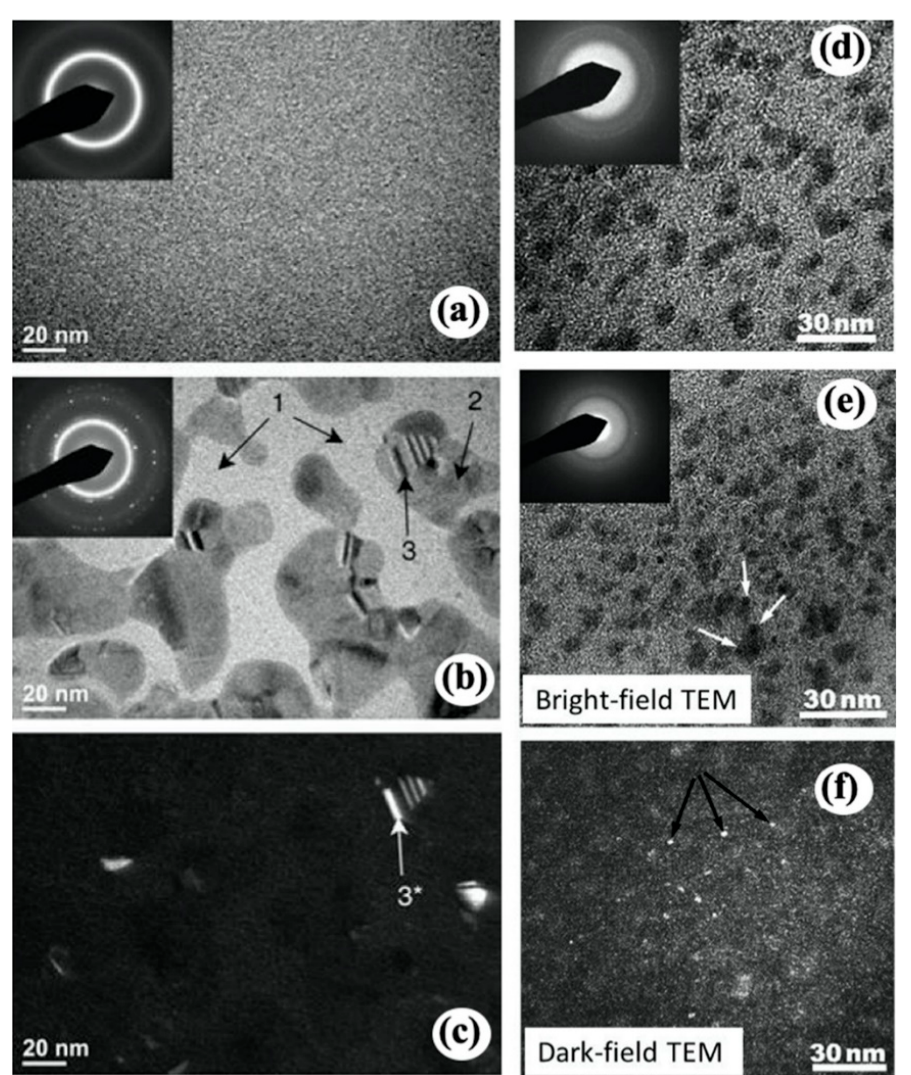
Figure 6. TEM images and corresponding diffraction patterns of ( a ) as-spun Ni 52.5 Nb 10 Zr 15 Ti 15 Pt 7.5 , ( b ) ion-irradiated specimen, and ( c ) the corresponding dark-field TEM image [108]. ( d ) Bright-field TEM image of Cu 50 Zr 45 Ti 5 metallic glass irradiated by 2 keV Ar ions without cooling and the corresponding diffraction pattern. ( e ) Bright-field TEM image of the specimen in ( d ) after exposure to high-fluence electron beam and the corresponding diffraction pattern [109]. Arrows indicate radiation-induced nanocrystals. ( f ) Dark-field TEM image of the specimen shown in ( d